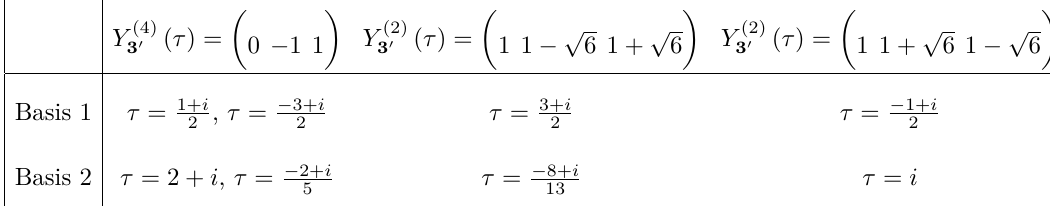
Table 2 . Relevant stabilisers to obtain the desired modular forms to achieve either a CSD(3.45) or a CSD(-1.45) model, both for basis 1 (used throughout this paper), and basis 2 used in [10]. For both cases, the charged leptons are at the left cusp: τ C = ω . Note that the convention of 3 and 3 0 is